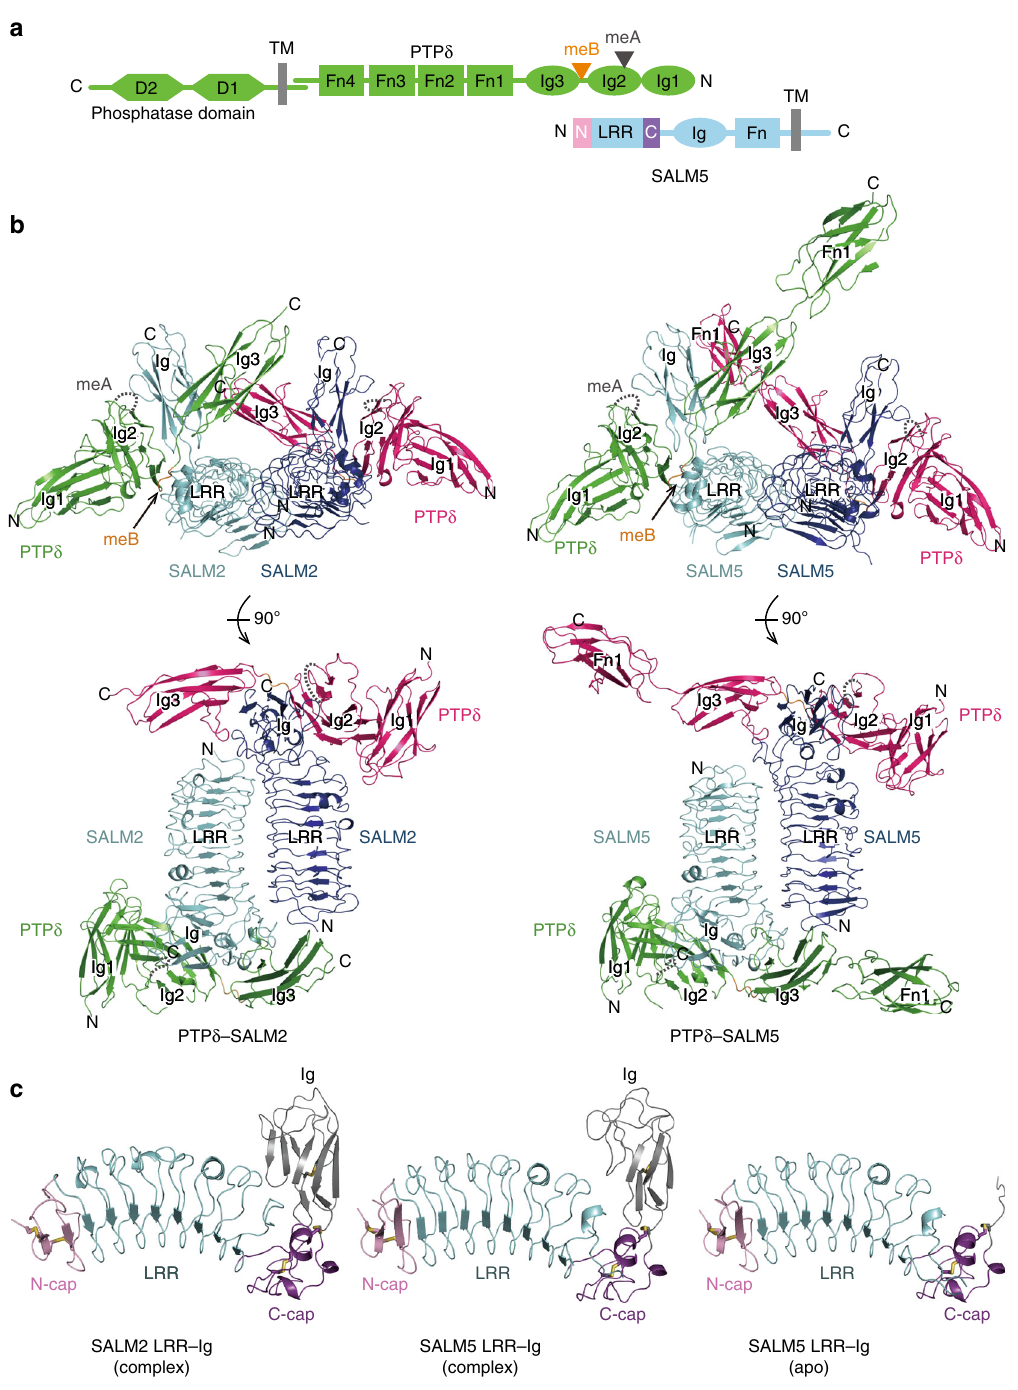
Fig. 1 Structures of PTP δ – SALM2 and PTP δ – SALM5 complexes. a Domain organizations of PTP δ and SALM5. b Structures of PTP δ – SALM2 and PTP δ – SALM5 complexes. Two complexes in the asymmetric unit are shown in two different orientations. PTP δ and SALMs in one complex are colored in green and cyan, respectively, whereas those in the other complex are colored in magenta and deep blue, respectively. The meB insertion in PTP δ are colored in orange. The disordered meA insertion is drawn as grey dotted lines. c LRR – Ig structures of SALM2 and SALM5. N-cap, LRR, C-cap, and Ig are colored in pink, cyan, purple, and grey, respectively. The disul fi de bonds are shown as yellow